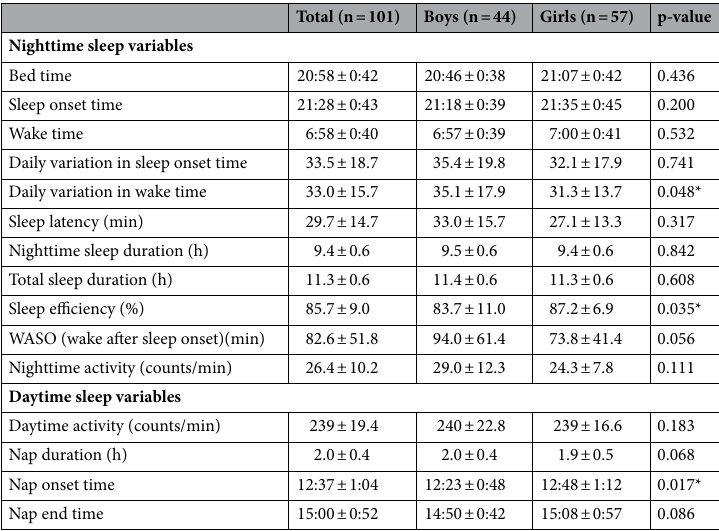
Table 3. Sleep variables by gender (mean ± s.d., *p <